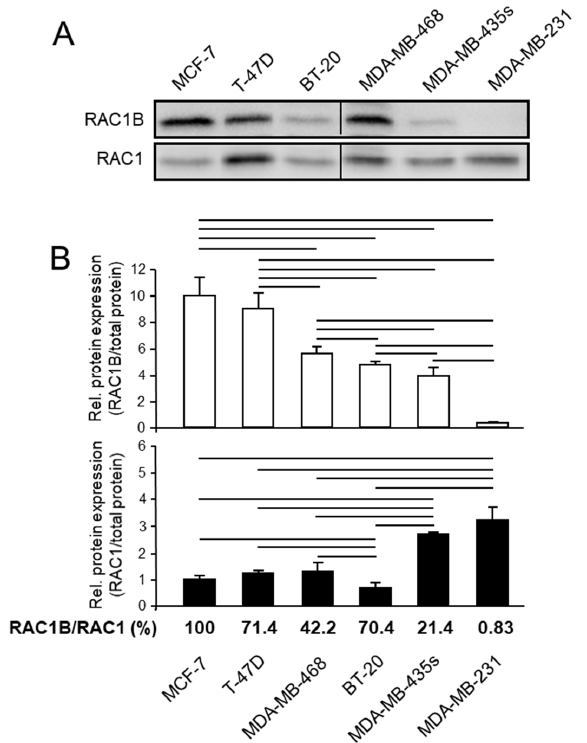
Figure 1. RAC1B and RAC1 expression in various established BC cell lines of either an epithelial or a mesenchymal phenotype. ( A ) Cells were grown to ~80% confluence before preparation of cell lysates and processing for immunoblotting with antibodies to RAC1B (upper blot) or RAC1 (lower blot). Shown is a representative blot. ( B ) The graphs show results from densitometric readings of RAC1B and RAC1 band intensities after normalization to the amount of total protein in the same lane. Data represent the combined results of three samples for each cell line taken at different times during continuous culture (mean ± SD, n = 3). The order of the cell lines was chosen according to their RAC1B protein content. The bars above the columns indicate significant differences ( p < 0.05). The ratios of RAC1B to RAC1 (RAC1B/RAC1) in the various cell lines are given below the graphs relative to that in MCF-7 cells set arbitrarily at